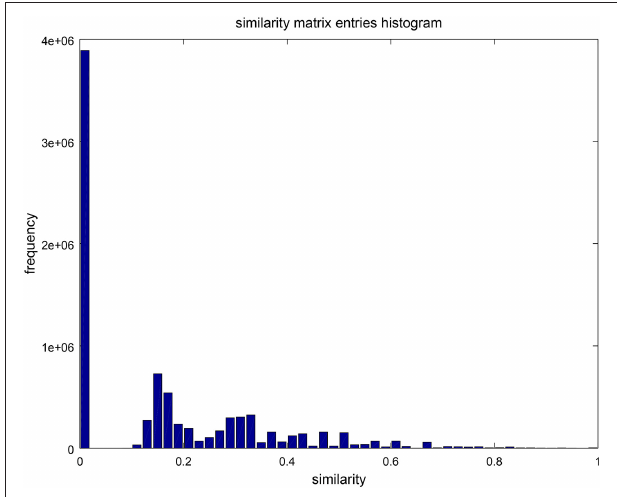
FIGURE 6 | A histogram with 30 bins, showing the distribution of entries in the similarity matrix of Figure 5 . Low similarity values are more frequent than high similarities reflecting high diversity in the sets of fixed-point